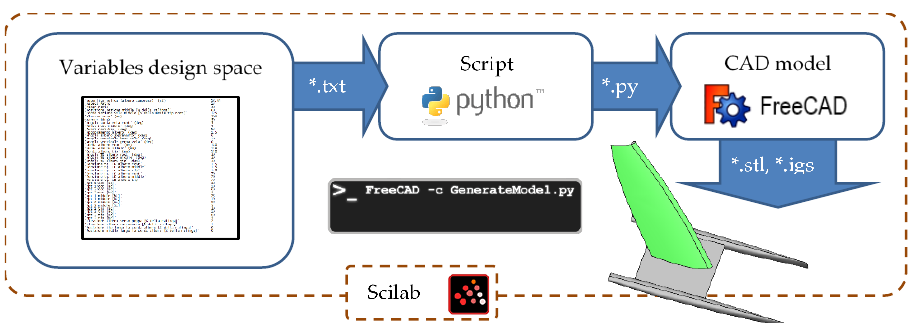
Figure 13. Scheme of the geometry generation module.